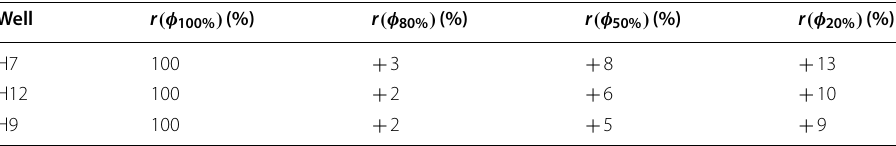
From the lack of a proper porosity–depth model for Los Humeros, this comparison took 3 different values of φ . r (φ 100% ) represents the porosity average for this well considering the value at lab conditions reported by Weydt et al. (2020). The entries r (φ 80% ) , (φ 50% ) , (φ 20% ) show the sensitivity on the radius calculation when the porosity decreases by 80, 50 and 20%, respectively. It can be seen that the radius is sensitive to these changes and the highest level of variation is when only 20% of the original value is considered